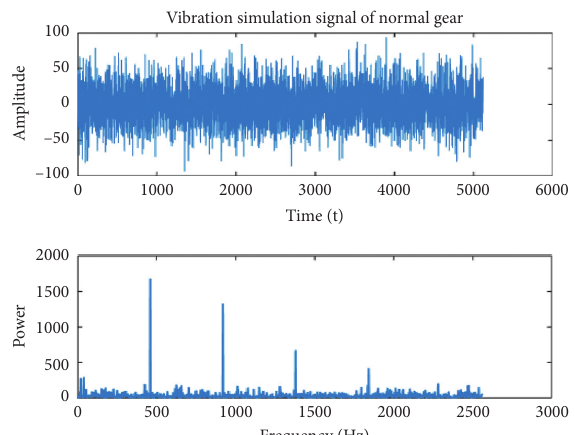
Figure 4: Vibration simulation signal of broken